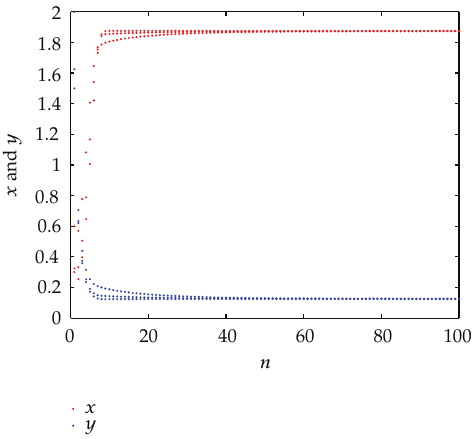
Figure 1: Solution curves of system (cid:6) 4.1 (cid:7) with initial conditions (cid:6) 1 . 625 , 1 . 325 (cid:7) , (cid:6) 1 . 5 , 0 . 6 (cid:7) , and (cid:6) 2 . 0 , 0 . 3 (cid:7) .